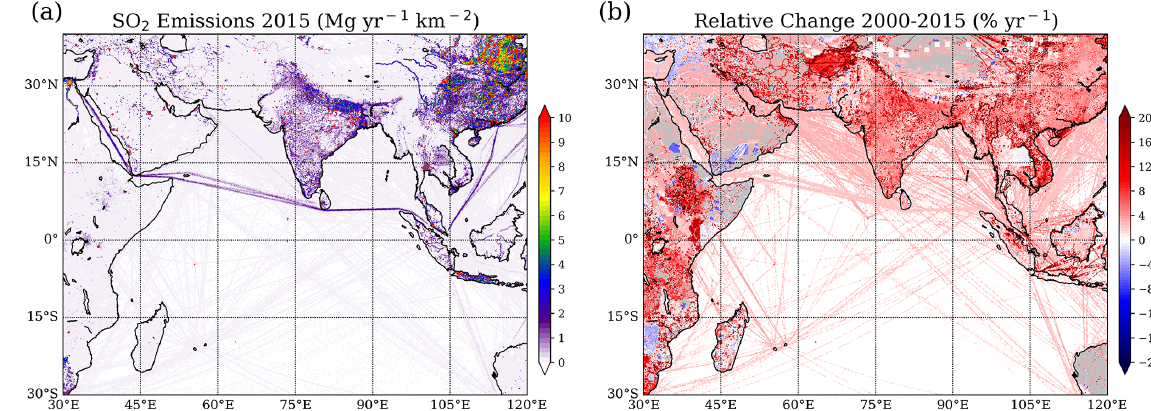
Figure 4. Annual mean SO 2 emissions for 2015 (a) and relative change with respect to 2000 (b) from EDGAR V5.0_AP.